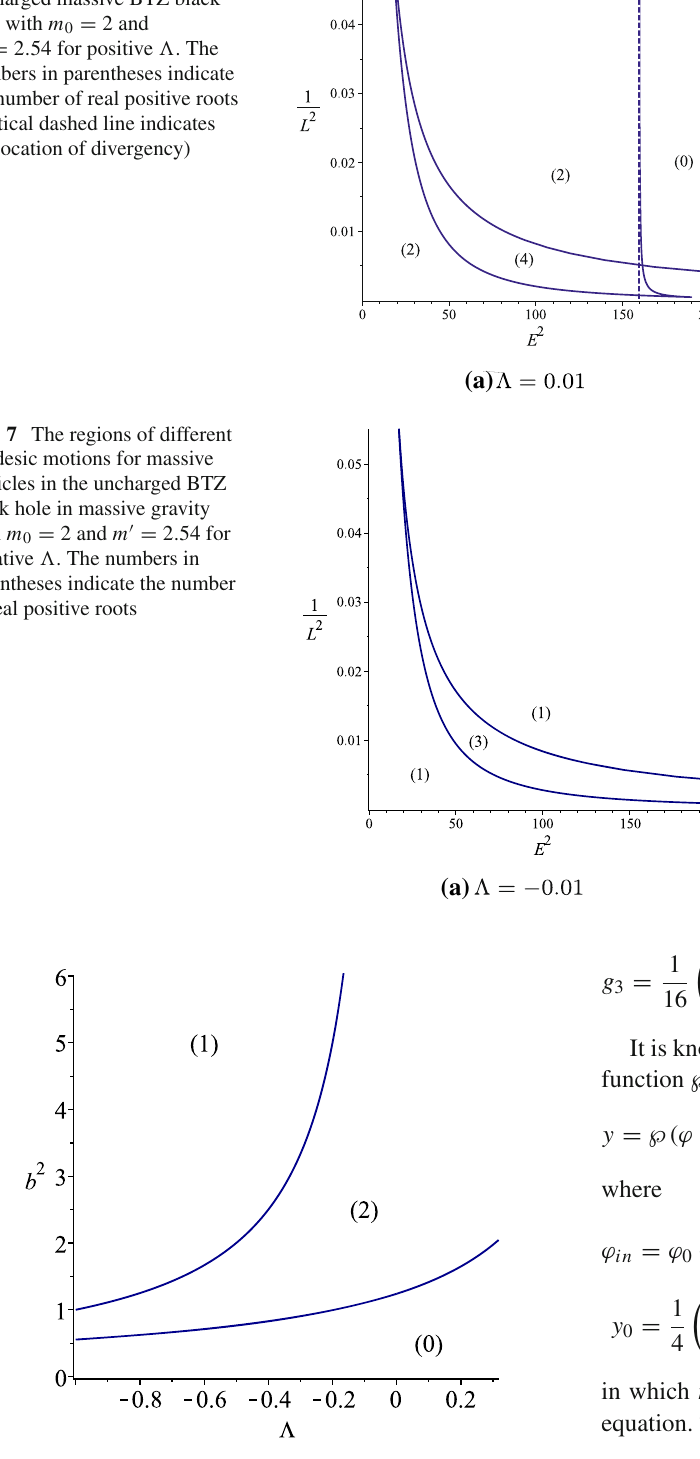
Fig. 6 The regions of different types of geodesic motions for massive particles in the uncharged massive BTZ black hole with m 0 = 2 and m (cid:5) = 2 . 54 for positive (cid:4) . The numbers in parentheses indicate the number of real positive roots (vertical dashed line indicates the location of divergency)